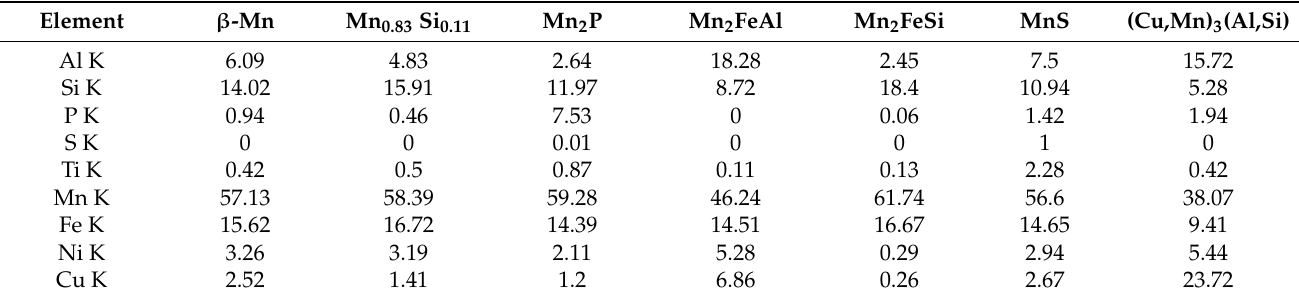
Table 4. Composition in at. % of phases in sample with 10% excess of aluminum measured by EDS. Measured compositions from areas investigated by EBSD are given. Error of measurement depends on number of counts in peak. Element